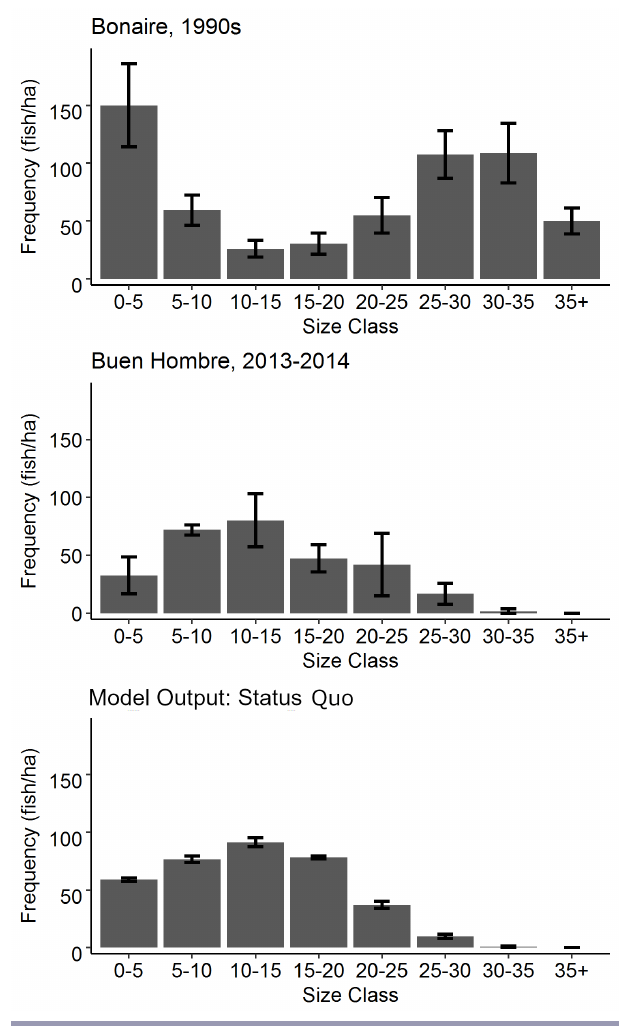
Fig. 1 . The size distributions of stoplight parrotfish ( Sparisoma viride ) in Bonaire (top) and Buen Hombre (middle) were nearly opposite one another. Bars in both distributions show the mean fish density, weighted by the proportion of habitat type in which fish were sampled. The error bars in the Bonaire data are 95% confidence intervals, whereas the error bars in the Buen Hombre data are the minimum and maximum values from 2 years of sampling. The simulated population structure under the status quo fishing scenario (bottom) when parameterized to the Buen Hombre fishery accurately reproduced key characteristics of the observed population. Size frequencies for the simulated population are the mean ending values from 3 runs, and error bars are standard